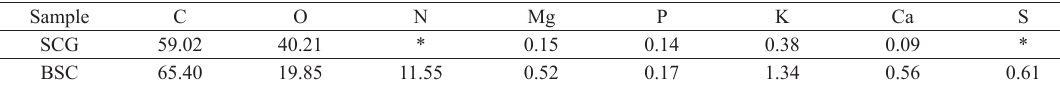
Table 1. EDS results (wt %) for SCG and